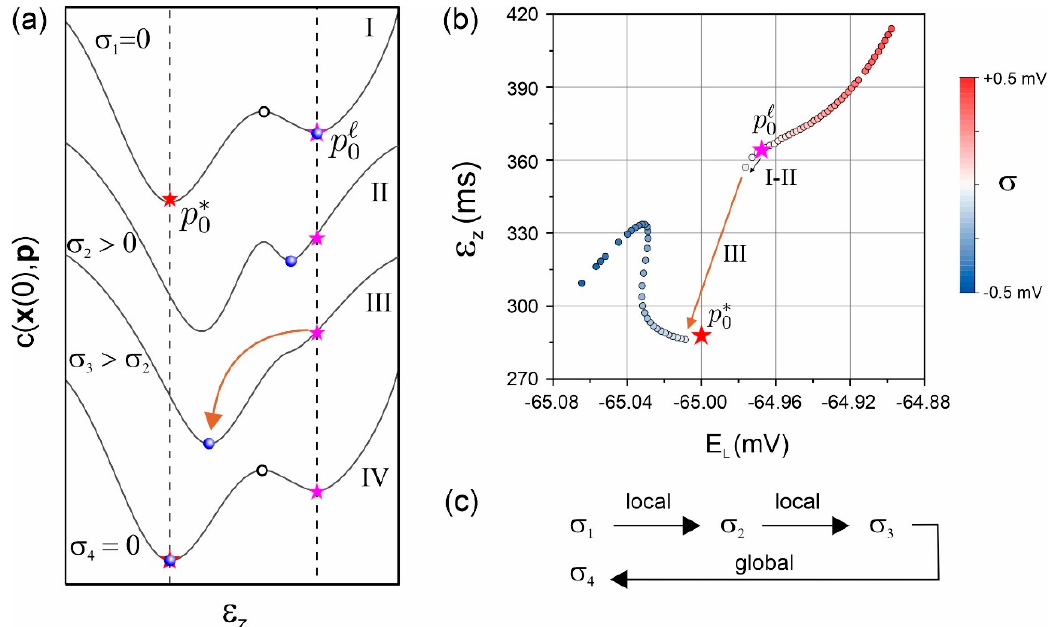
Figure 3. Regularization by noise. ( a ) The cost function plotted as a function of one parameter has local minimum 𝑝 (cid:2868)(cid:3039) in the vicinity of the global minimum 𝑝 (cid:2868)∗ . The parameter estimation algorithm started from an initial guess at the local minimum (pink star). Then, the amplitude of noise was increased. Until a critical value, the parameter solution remains in the local minimum but shifts (blue dot). Above this critical value, at 𝜎 (cid:2871) , the local minima and the global minimum merge, causing an abrupt jump of the solution into the (noise shifted) global minimum. The global solution above 𝜎 (cid:2871) then need to be inserted as input to the parameter estimation algorithm, and then, noise is pro- gressively decreased to zero to obtain the global minimum at zero noise. ( b ) Trajectory of the neuron parameter vector projected in two dimensions as noise is varied. A jump is observed from the local to the global solution. ( c ) Schematics of the noise annealing protocol [11].